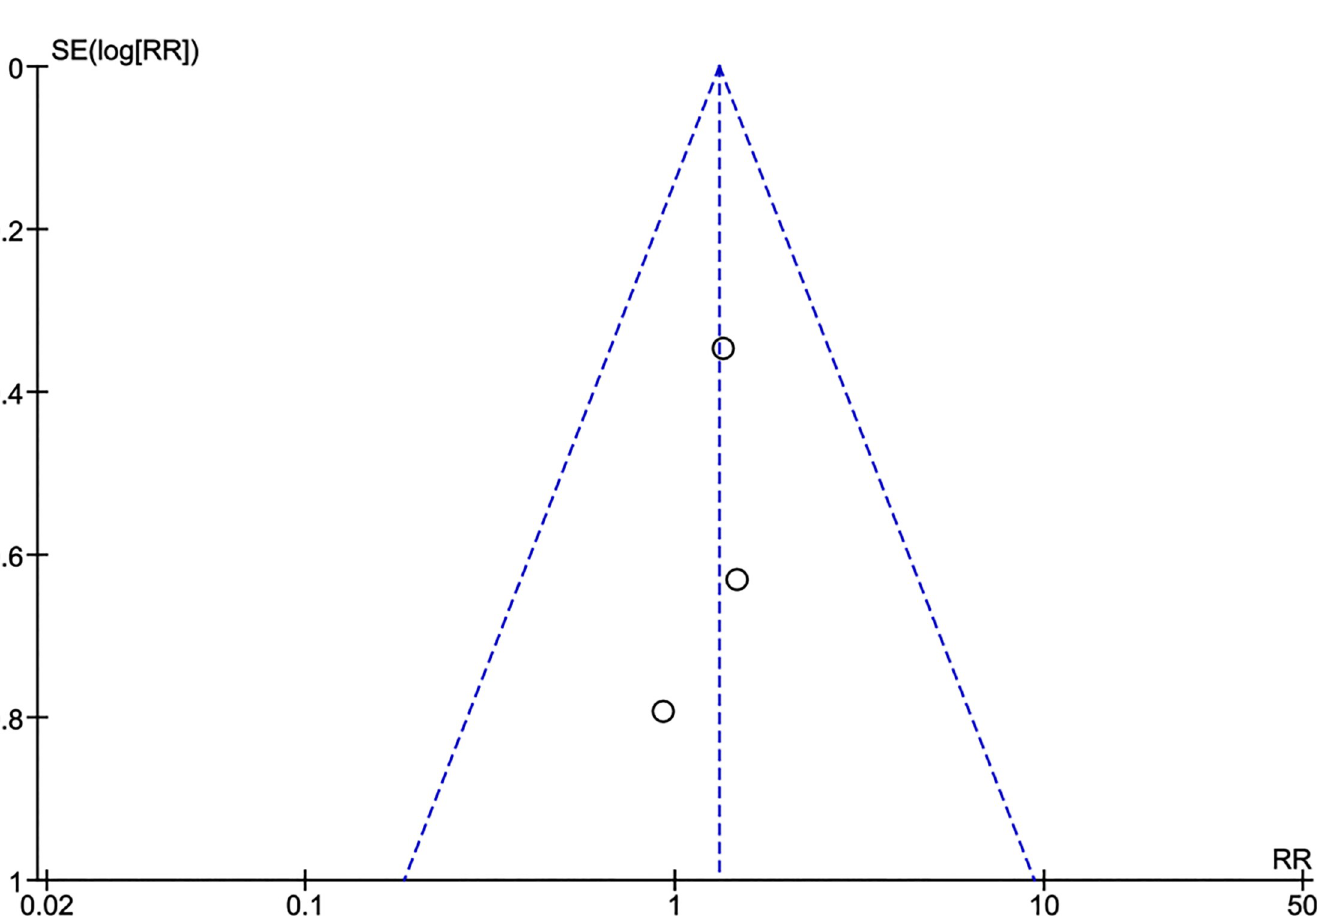
PLOS NeglectedTropical Diseases | https://doi.org/10.1371/journal.pntd.0009193 March 31,